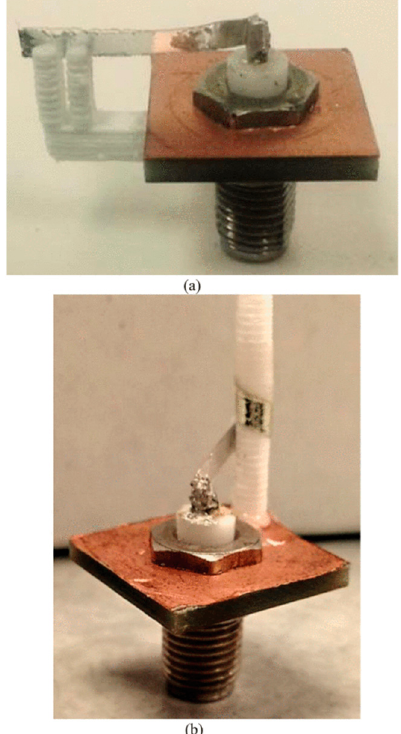
Figure 10. Pattern and frequency-reconfigurable antenna based on liquid crystalline elastomers: ( a ) straight statues; ( b ) helix structure with 1.1-turn [113].